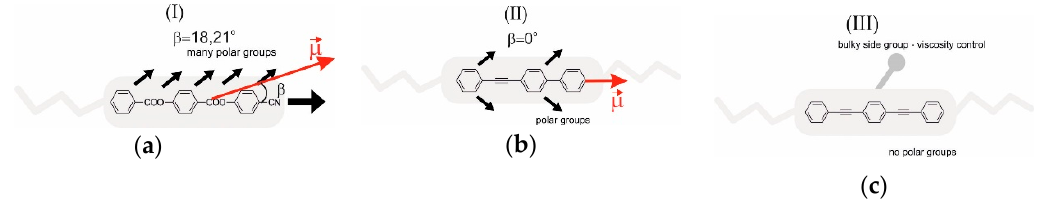
Figure 1. The structures of the three different groups forming the mixture: ( a ) component I, ( b ) component II and ( c ) component III. Red arrows indicate the position of the molecular dipole moments.